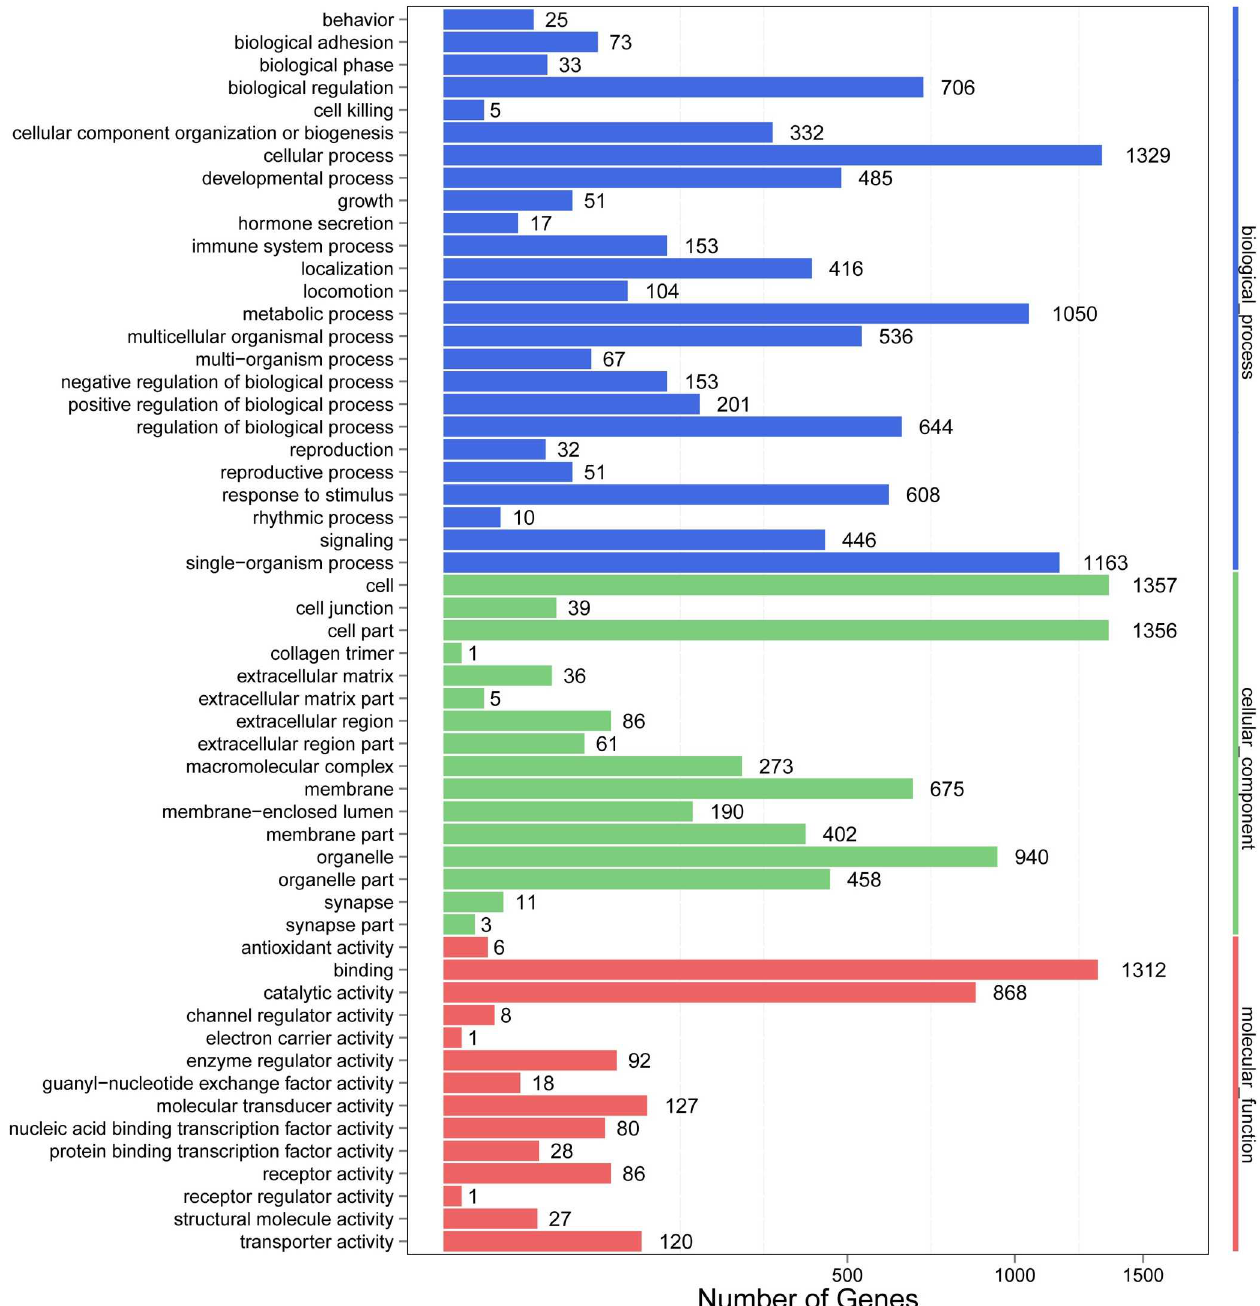
Fig 1. GO enrichment in the muscle transcriptome of the Hyb. The left y-axis indicatesthe identified GO terms. The right y-axis indicatesthe three groups of GO enrichment. The down x-axis representsthe number of genesin certain